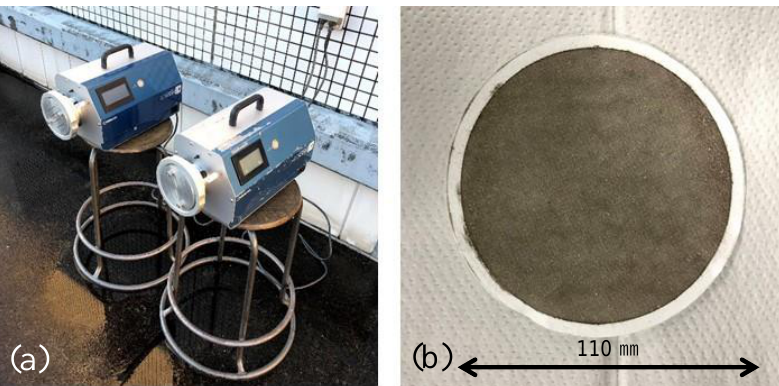
Figure 2. ( a ) High-volume air samplers and ( b ) typical PM 2.5 samples collected on the titanium dioxide-supporting quartz fibre filter (TiO 2 filter).